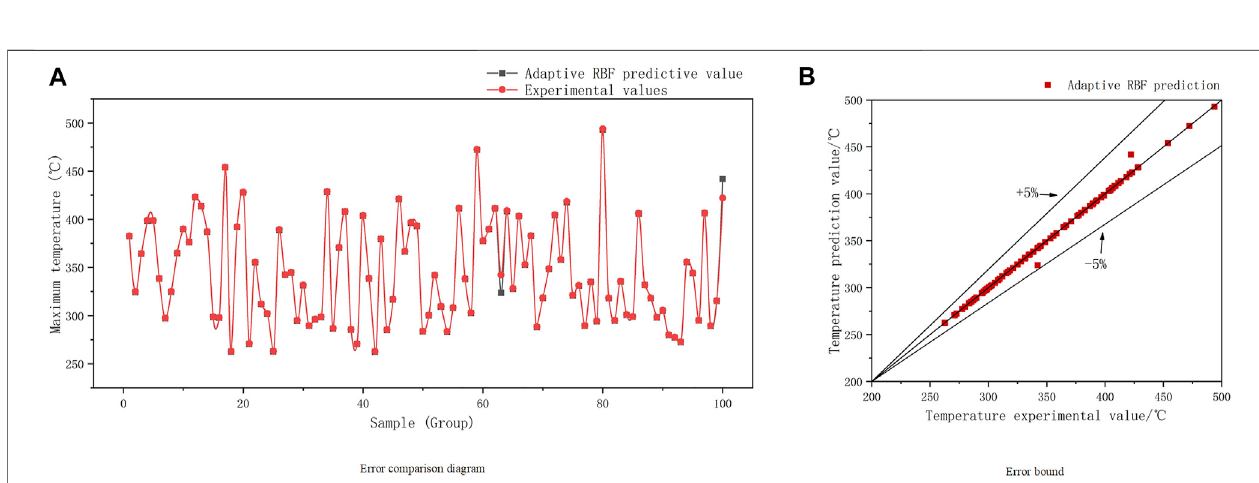
FIGURE 6 | The error comparison diagram and the error bound of adaptive RBF neural network.